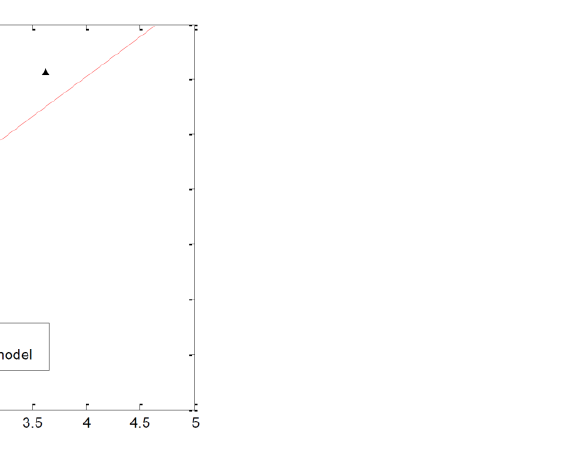
Figure 14. Ice resistance obtained by Lindqvist formula and simulated with FEM-PD coupling model for different speeds.